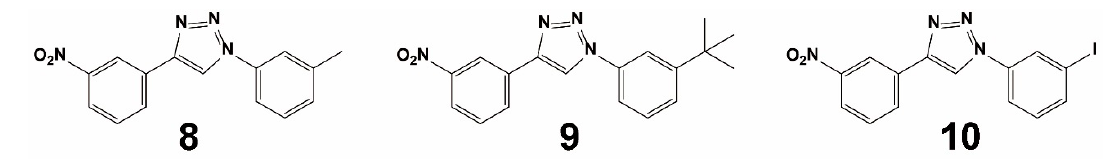
Figure 7. Structures of compounds 8–10 .